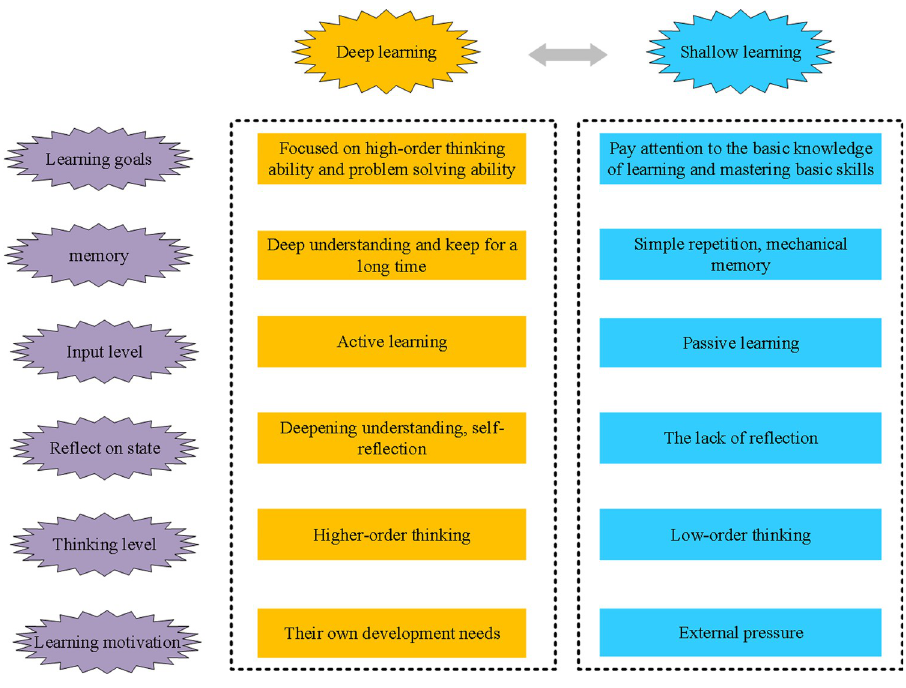
Fig 1. Comparison between deep learning and shallow learning.